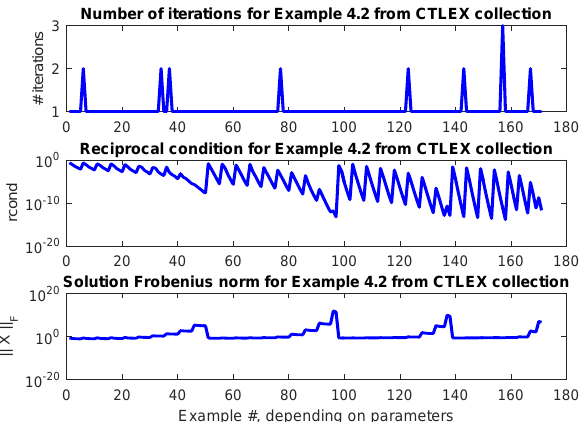
Figure 4. Number of iterations for ArLyap solver, reciprocal condition numbers, and computed solution norms for CTLEX 4.2 series of